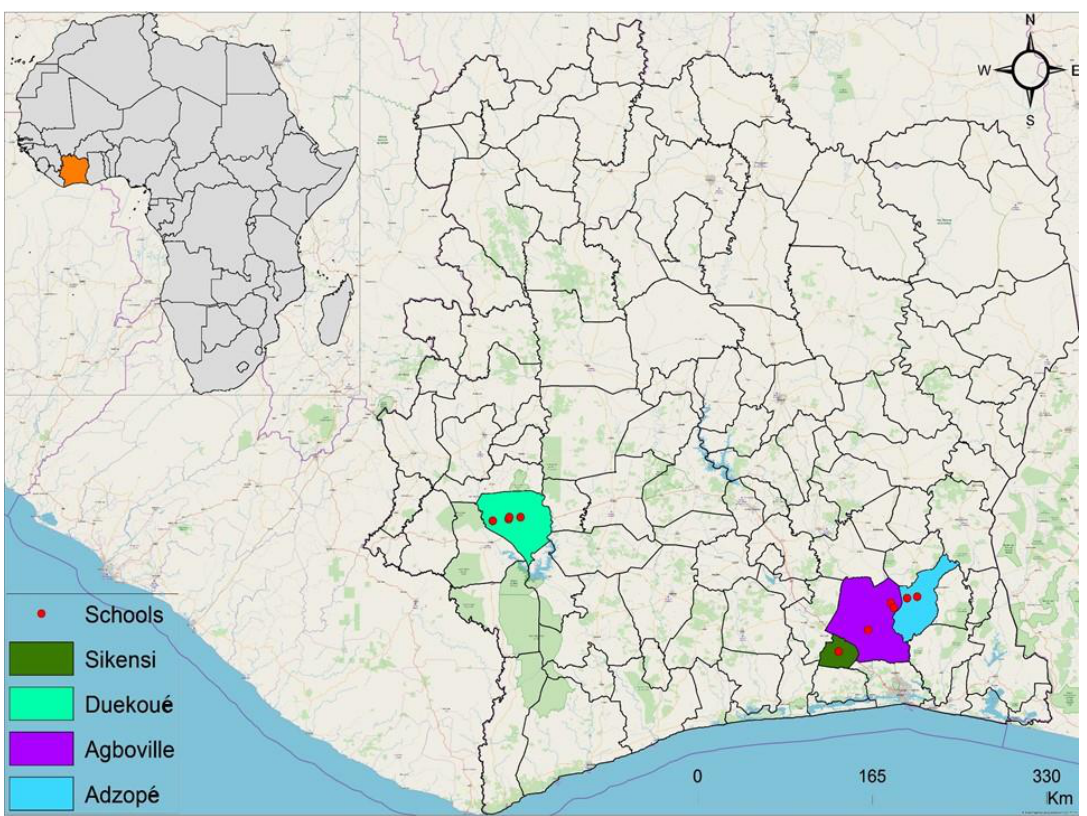
Figure 1. Collection of maps displaying the study area in Côte d’Ivoire, West Africa: Adzopé, Agboville, and Sikensi in the southern setting; Duekoué in the western setting of Côte d’Ivoire. Primary schools (red dots) were selected in each health district on the basis of close proximity to open freshwater bodies (distance: < 10 km).